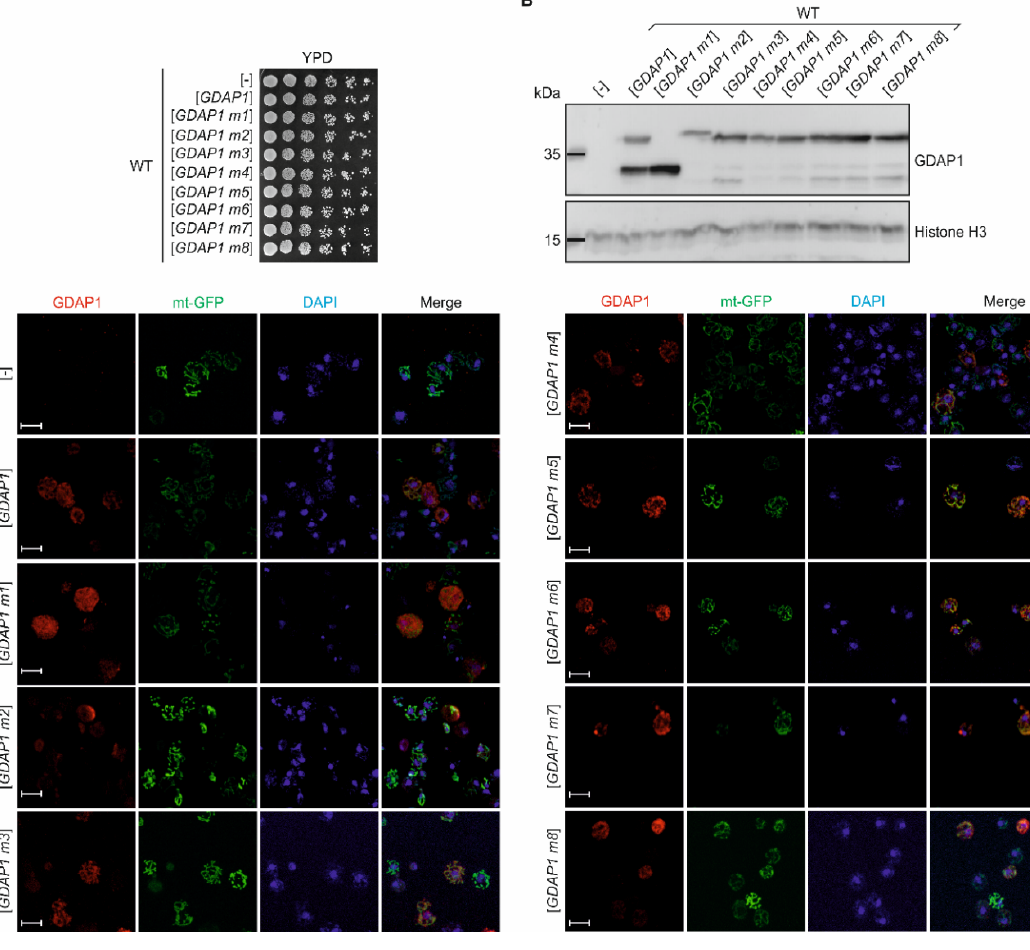
Figure 2. Yeast-based system to analyze GDAP1 protein function. ( A ) Overnight cultures of wild-type yeast cells harboring empty vector ([-]) or plasmids with GDAP1 gene variants were diluted to OD 600 ≈ 1 and then ten-fold serial dilutions were prepared and spotted on to YPD medium. Plates were incubated for 2 d at 28 ◦ C. ( B ) Yeast wild-type cells harboring empty vector ([-]) or plasmids with GDAP1 gene variants (as indicated) were cultured overnight in SC-leu at 28 ◦ C, then were collected and disrupted. The total cell extracts obtained were analyzed by SDS-PAGE, followed by immunoblotting with anti-GDAP1 or anti-Histone H3 antibodies, as indicated. ( C ) Yeast wild-type cells transformed with plasmid encoding mitochondrially targeted green fluorescent protein (mt-GFP) and with empty vector ([-]) or plasmids encoding GDAP1 alleles (as indicated) were grown in SC–leu-his medium overnight and then were shifted to glycerol-containing medium for 4 h to induce expansion of mitochondria. Cells were fixed, stained and observed using confocal microscopy. GDAP1 was visualized by immunostaining (red), mitochondria using the mt-GFP protein marker (green) and the nucleus was stained with DAPI (blue). Scale bar 5 µm.